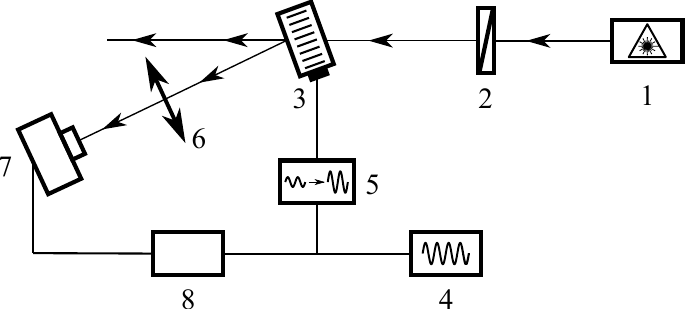
Figure 4. Schematic diagram of experimental setup: 1—FEL; 2—wire-grid polarizer; 3—AO cell; 4—signal generator; 5—electrical amplifier; 6—lens; 7—Golay cell; 8—lock-in amplifier.